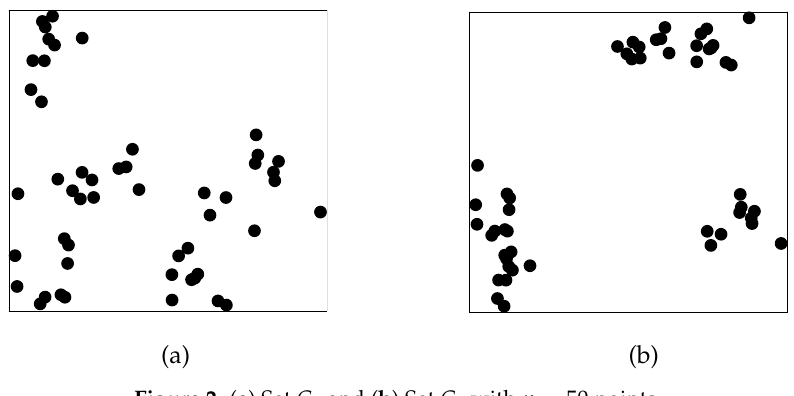
Figure 2. ( a ) Set C 1 and ( b ) Set C 2 with n = 50 points. Table 2. Execution times and accuracies for symmetric Nonnegative Matrix Factorization (NMF) problems.